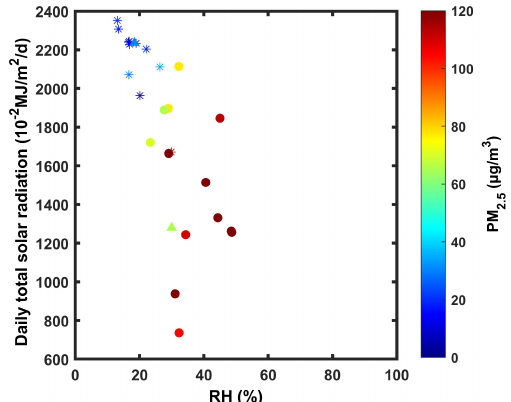
Figure 3. Scatter plot of NPF days (asterisks), non-event days (cir- cles), and undefined days (triangles) between daily total radiation and RH, color-coded with PM 2 . 5 mass